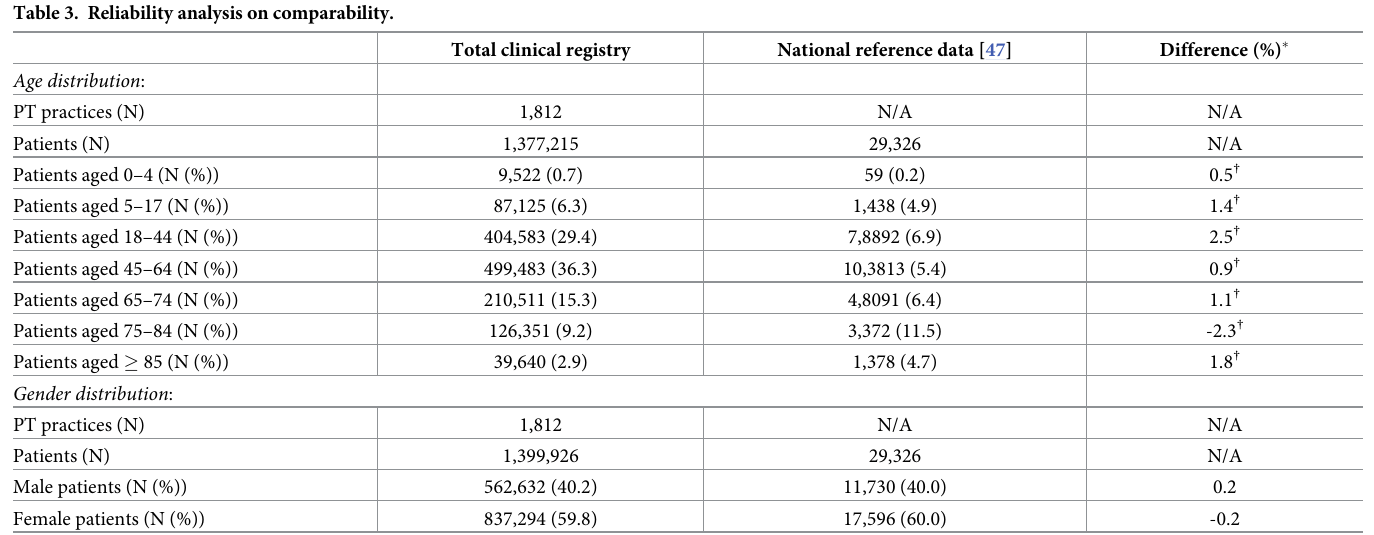
Table 3. Reliability analysis on comparability.